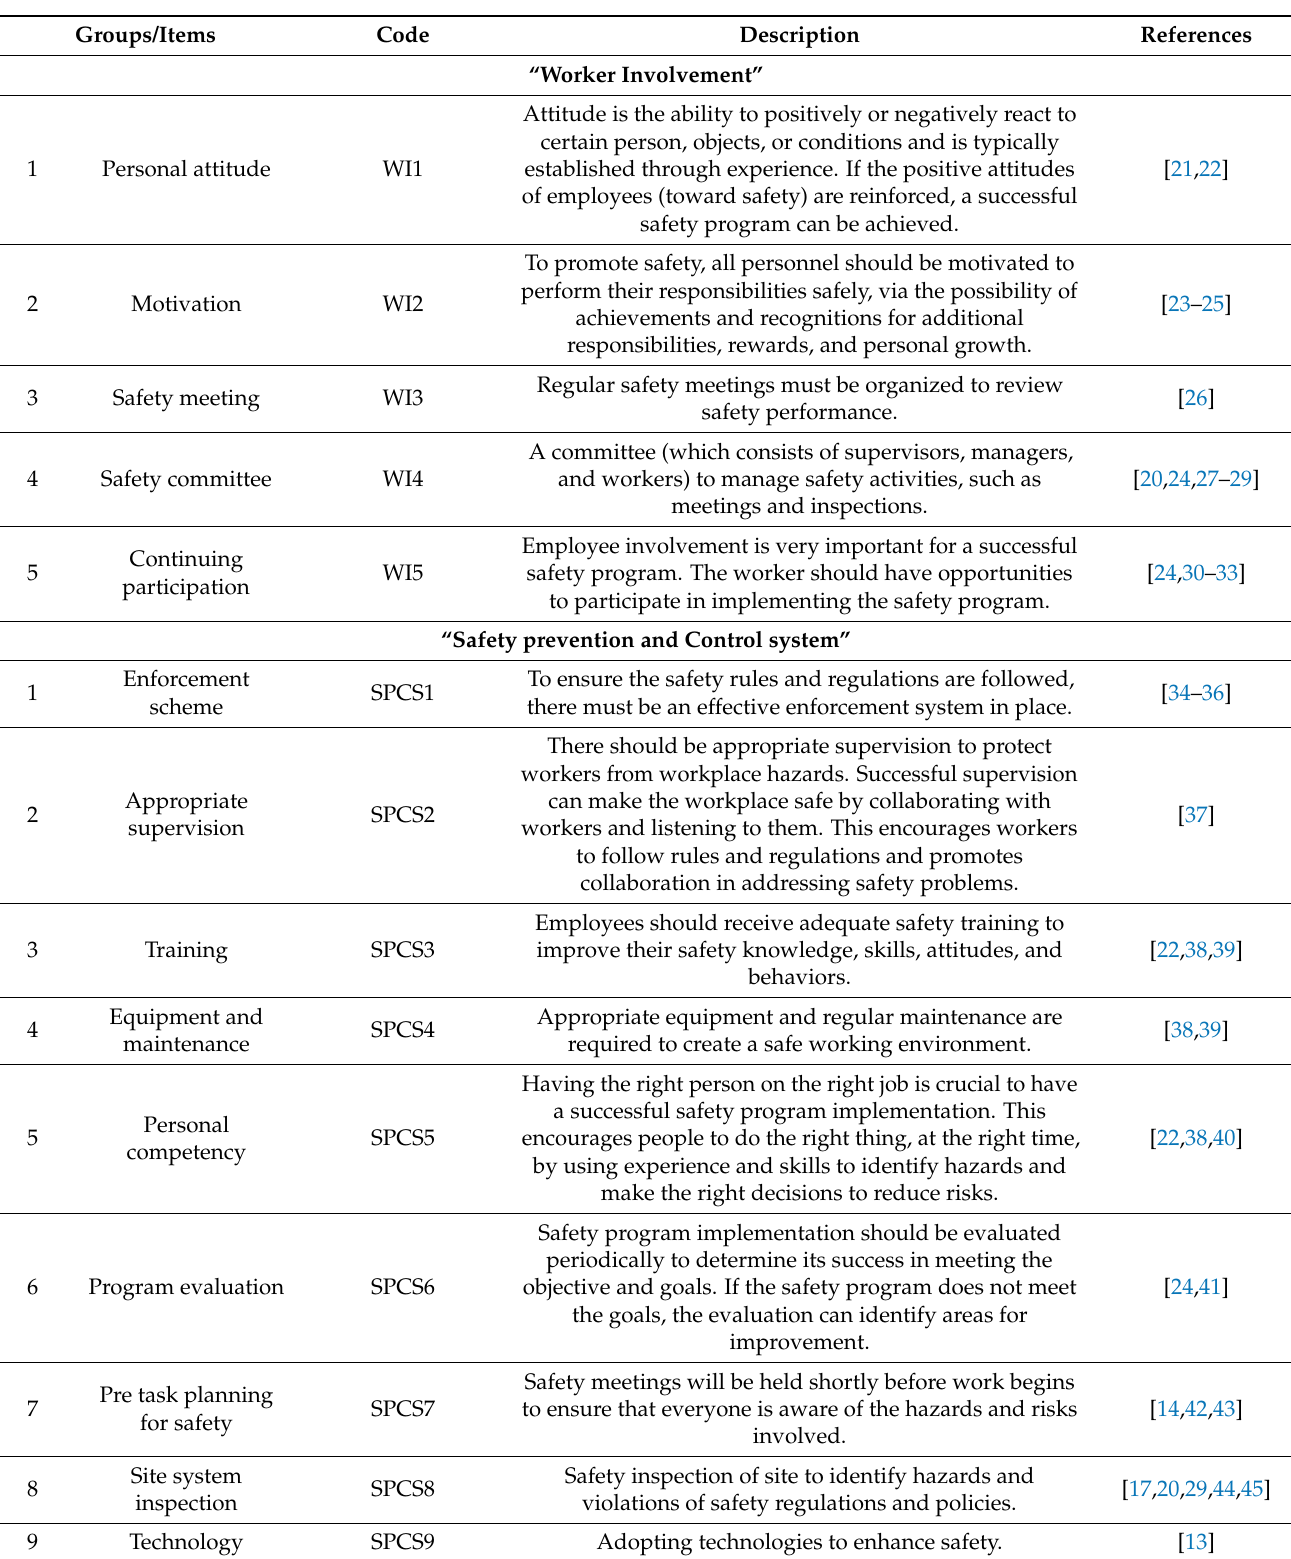
Table 1. Critical success